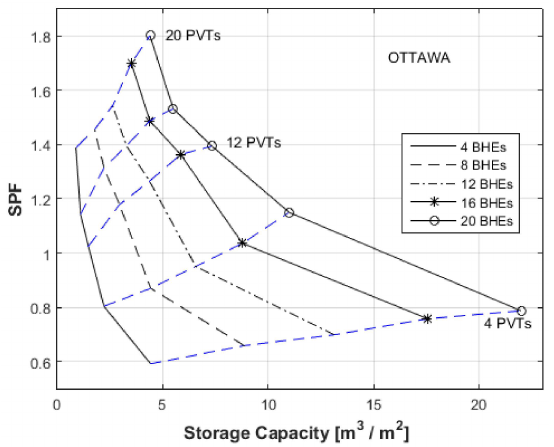
Figure 9. Annual seasonal performance factor as function of the storage capacity for